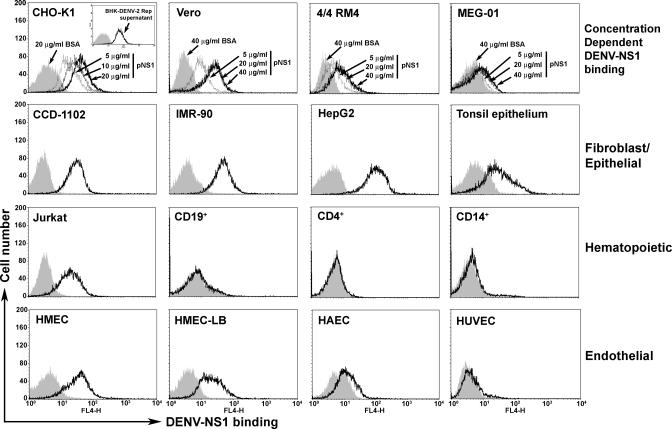
DENV NS1 Binds to Cells of Specific LineagesDose-dependent binding of DENV NS1 to cell surfaces. Purified DENV NS1 (5, 10, 20, and 40 μg/ml) was added to different cell types at 4 °C for 1 h. After washing, bound NS1 was detected by anti-NS1 antibody staining and flow cytometry. An example of DENV NS1 binding to CHO-K1 cells using supernatant from BHK-DENV-2 Rep cells is depicted in the inset at the upper right corner of the top left histogram. Examples of histogram profiles of DENV NS1 binding to epithelial, fibroblast, hematopoietic, and endothelial cells are depicted. One representative of three experiments is shown. No specific staining was observed after BSA binding and incubation with an NS1 antibody or NS1 binding and incubation with an isotype-matched control antibody (unpublished data).